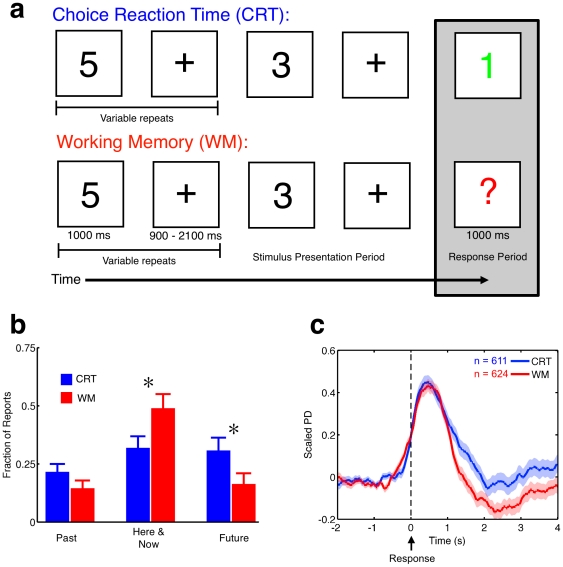
Task description, experience sampling and motor-related pupil response.(a) A schematic illustrating the choice reaction time (CRT, blue) and working memory (WM, red) tasks. In the CRT task, correct responses can be made without attention to the non-colored stimuli; this is not true in the WM task. (b) Results of Experiment One. Thirty participants who performed above chance for both the WM and CRT tasks were included in the analysis. Participants were asked on 18 occasions whether their attention was focused on the here and now (the task), the future, or the past. A 2×3 analysis of variance (ANOVA) was conducted on the experience sampling data with two factors of task [WM/CRT] and three factors of experience [“Future”/ “Here and Now”/ “Past”]. This analysis indicated a Task×Experience interaction (F (2, 58) = 8.51, p<.001, η2 = .23) in which thoughts of the “Here and Now” were more frequent in the WM task (p<0.001) and “Future” thoughts more prevalent in the CRT (p<0.01). “Past” thoughts did not vary across tasks (p = .11). (c) Scaled pupil diameter time locked to all responses in the WM and CRT tasks. Thirteen subjects from Experiment Two passed quality control cutoffs. Shaded regions indicate one standard error of the mean, and the response instant at t = 0 is indicated with a dashed line and arrow. In both the WM and CRT tasks the expected robust motor component [49] to pupil size is observed.